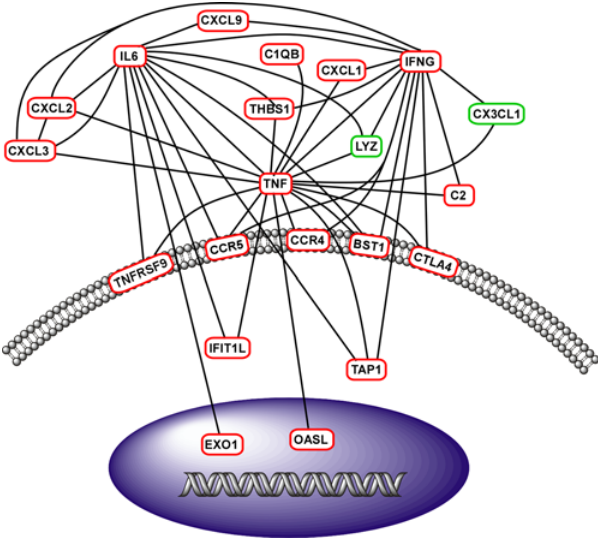
Figure 4. Gene network analysis identifies putative mediators of PbA-induced ALI. A gene-gene interaction network of differentially expressed lung homogenate cytokines and defense/immune response genes in the PbA infection model was created from known gene product interaction databases (Ingenuity, Adriadne and Human Protein Reference Database). Red circles denote upregulated genes and green downregulated genes. Nodes with high interconnectivity, including IFN- c , TNF and IL-6, may be important mediators of PbA-induced ALI.